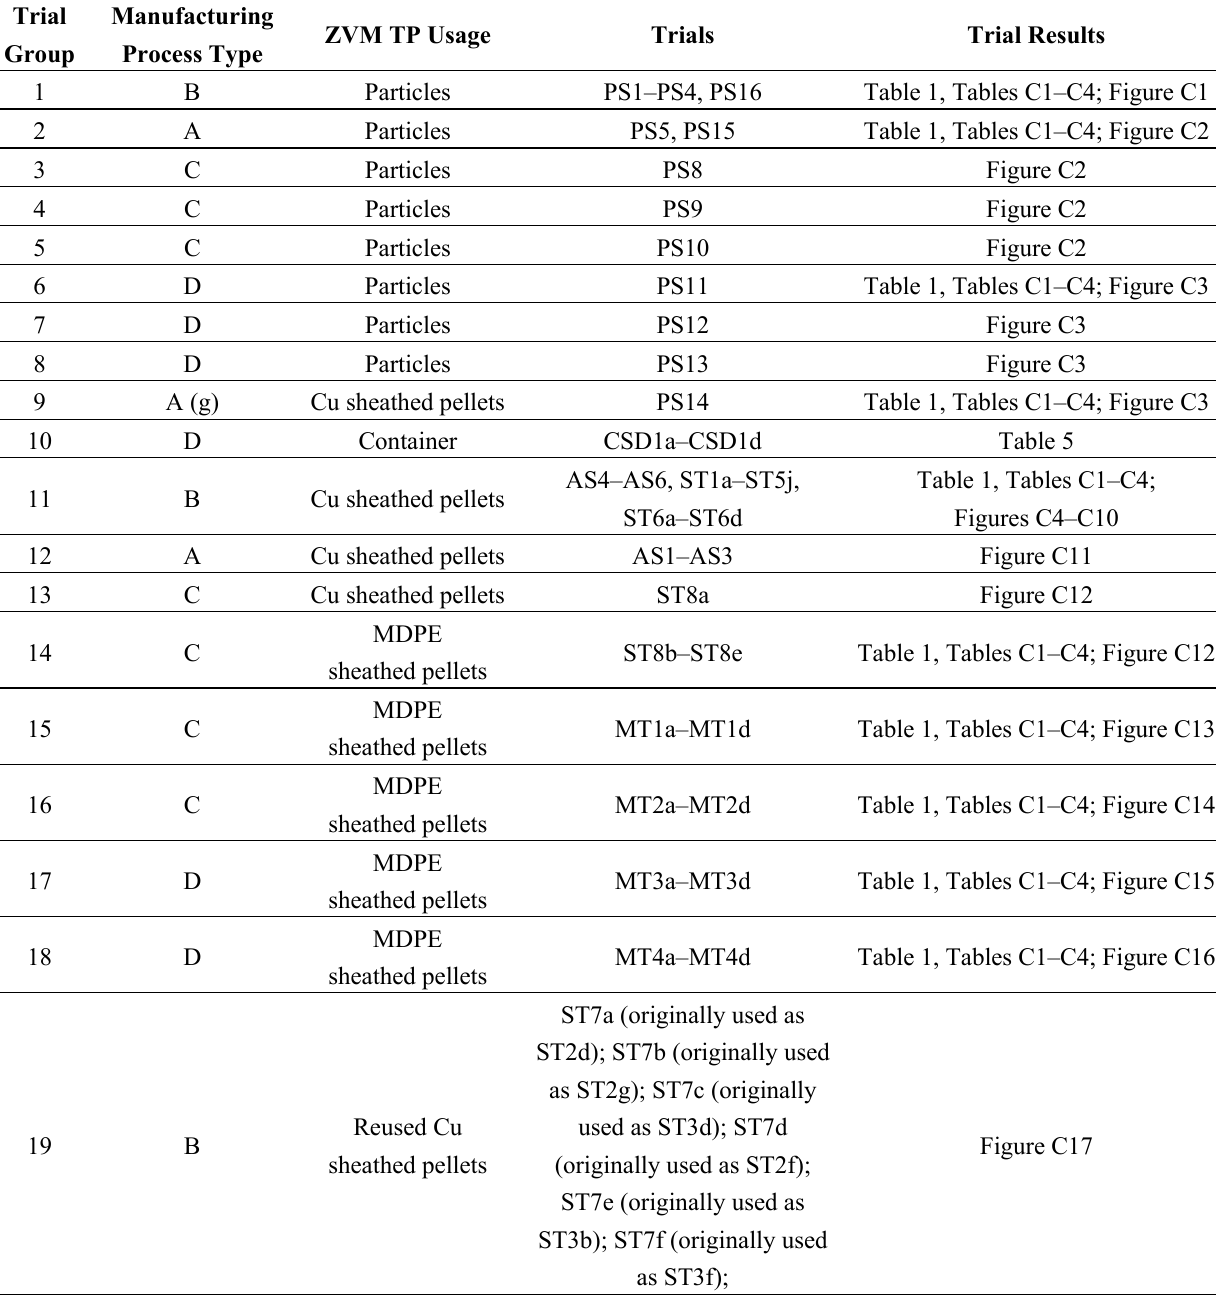
Table D1. ZVM TP Manufacturing Processes and Trials; Cu sheathed pellets are 15 mm OD. MDPE sheathed pellets are 20 mm and 25 mm OD. A (g) indicates that the trial